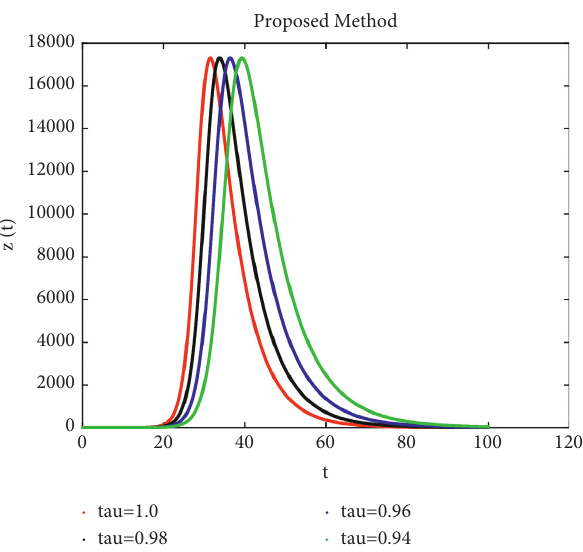
Figure 14: Dynamical behavior of free HIV virus particles at α � 1 and various fractal order under Mittag-Leffler kernel.